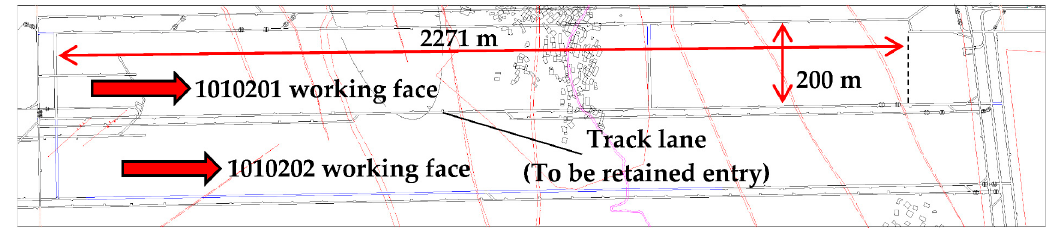
Figure 2. Plan of the 1,010,201 working face.